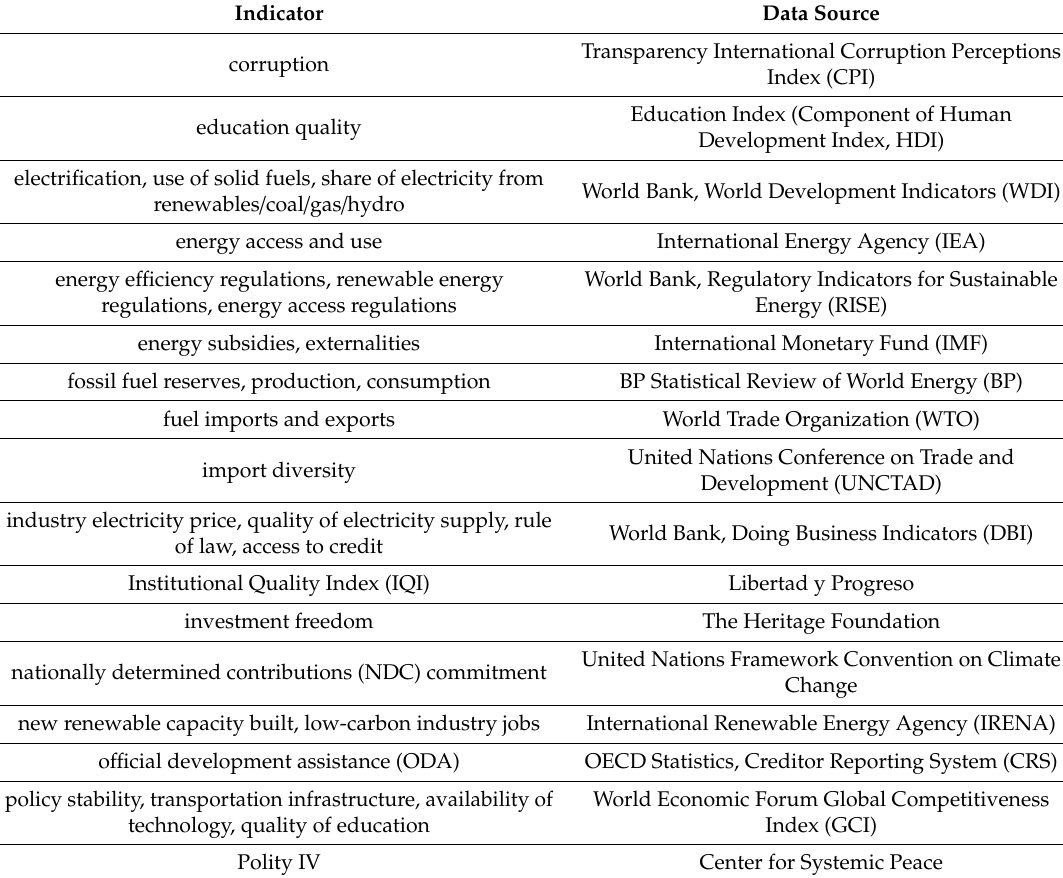
Table A1. Data Sources (Source: